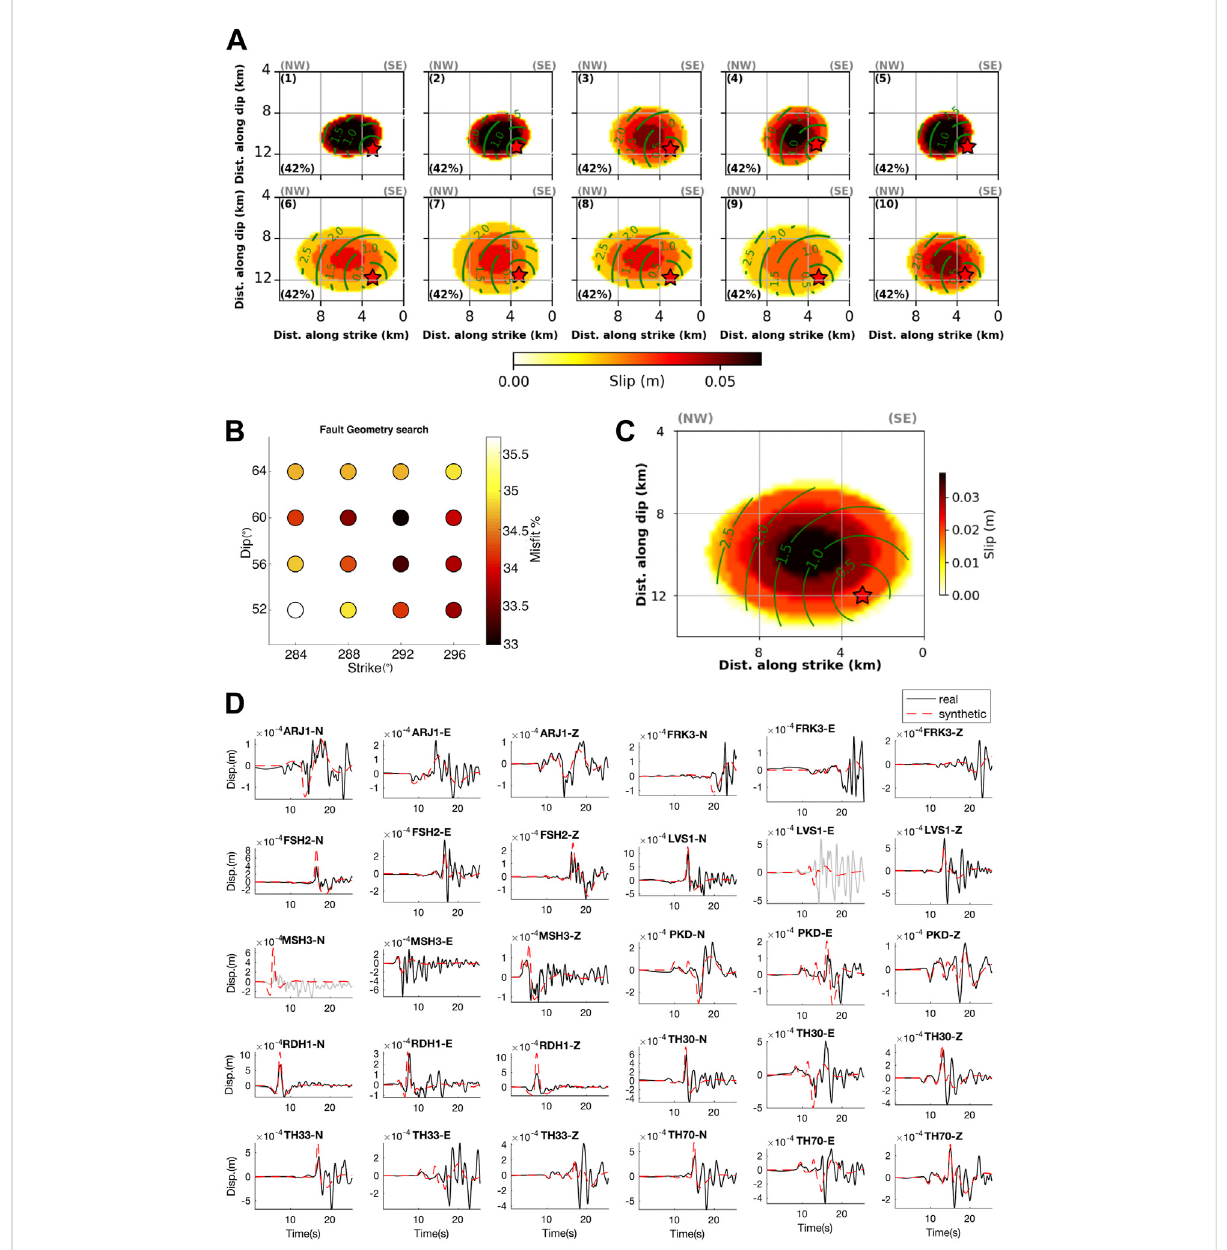
FIGURE 3 (A) :10 fi nalrupturemodelsfor themainshock obtained on thepreferred geometryobtained during independent inversions,assumingdifferent rangesfortheruptureparameters. (B) Gridsearchofthegeometryoftherupturedarea. Thepreferredgeometryhasastrike/dipof292 ° /60 ° . (C) Best rupture model for the mainshock. (D) waveform fi t of the best rupture model shown in (C) . Gray waveforms were not used in the inversion; their corresponding synthetic waveforms were obtained by forward